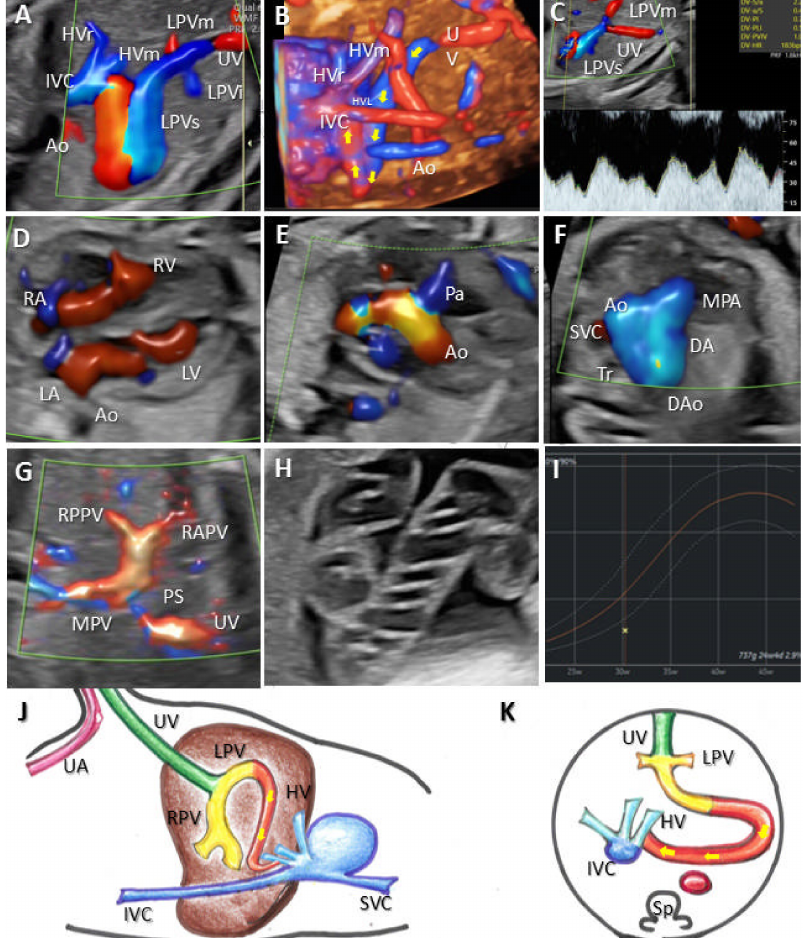
Figure 5. Type IIIa shunt with intrahepatic drainage of the umbilical vein at 30 weeks of gestation (Case 16) ( A ) Color Doppler imaging, showing in the oblique–transverse plane the connection between the superior branch of the left portal vein and the left hepatic vein ( B ) Four-dimensional STIC rendering of the abdominal vessels showing the pathway of the shunt. ( C ) Transverse view at the level of insertion of the umbilical cord showing intrahepatic drainage of the shunt and the biphasic aspect of the velocity. ( D ) Four-chamber view color Doppler assessment with flows separated by the interatrial and interventricular septum. ( E ) Color Doppler imaging, showing the left ventricular outflow tract in the axial plane. ( F ) Three vessels and trachea view showing the superior vena cava, pulmonary artery, ductus arteriosus, transverse aortic arch (from the proximal aorta to the descending aorta), and trachea. ( G ) Transverse plane of the fetal abdomen showing the typical UV confluence and portal venous system features. ( H ) Two-dimensional imaging of the hyper-coiled umbilical cord. ( I ) Graph of the fetal weight demonstrating a low percentile for the gestational age. ( J , K ) Schematic diagram of type III shunt. ( J ) Sagittal and ( K ) axial plane with abnormal connection between the superior branch of the left portal vein and the left hepatic vein. LPVi, the inferior branch of the left portal vein; LPVm, medial branch of the left portal vein; IVC, inferior vena cava; UV, umbilical vein; HVr, right branch of the hepatic vein; HVm, medial branch of the hepatic vein; HVl, left branch of the hepatic vein; Ao, aorta; Sp,